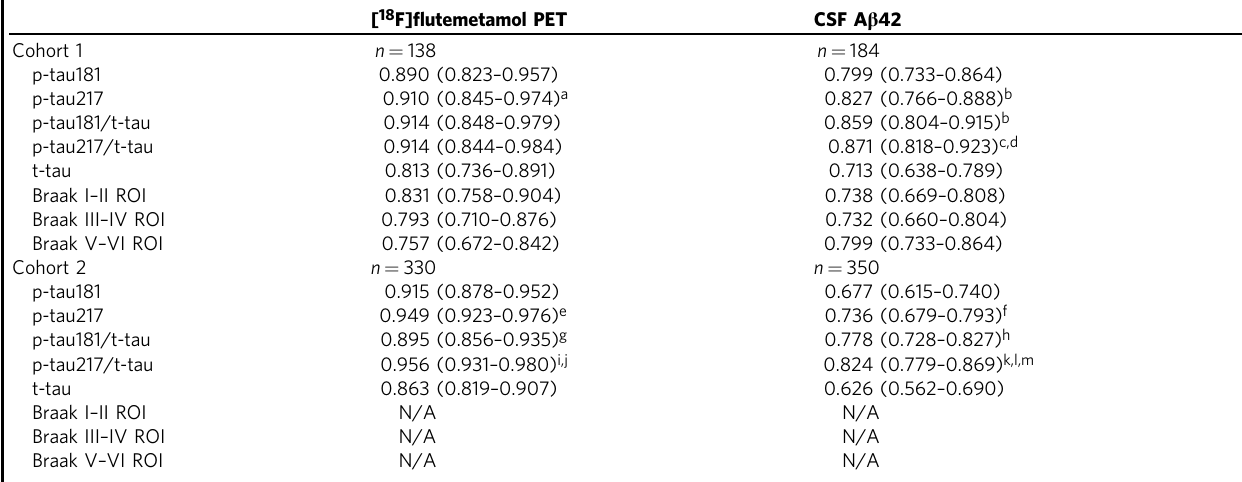
Table 4 ROC analysis of CSF tau variants for identifying abnormal amyloid